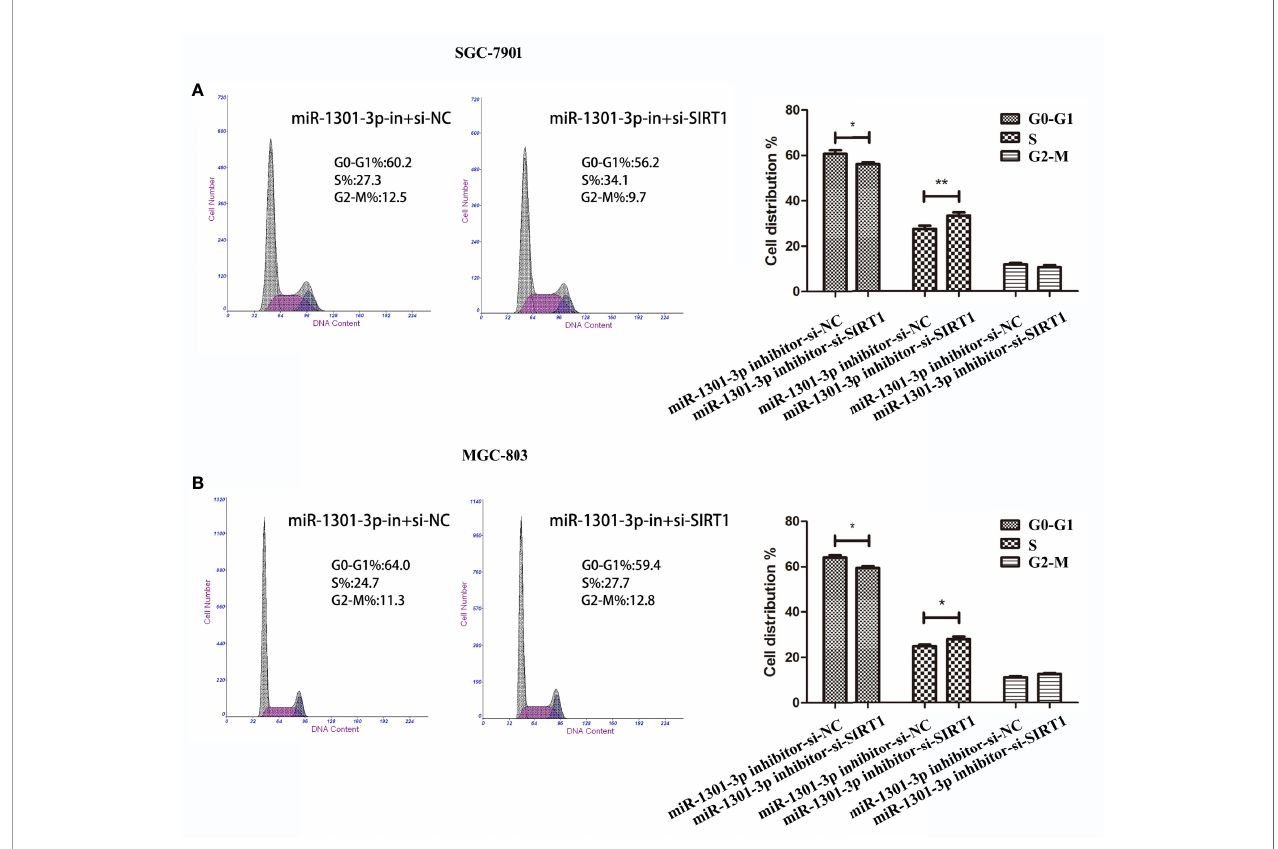
FIGURE 8 | Cell cycle assay demonstrated that knockdown of SIRT1 and miR-1301-3p simultaneously promoted cell cycle progression. (A, B) Cell cycle assay in SGC-7901 and MGC-803 cells transfected with miR-1301-3p-in+si-NC and miR-1301-3p-in+si-SIRT1. *p < 0.05, **p <